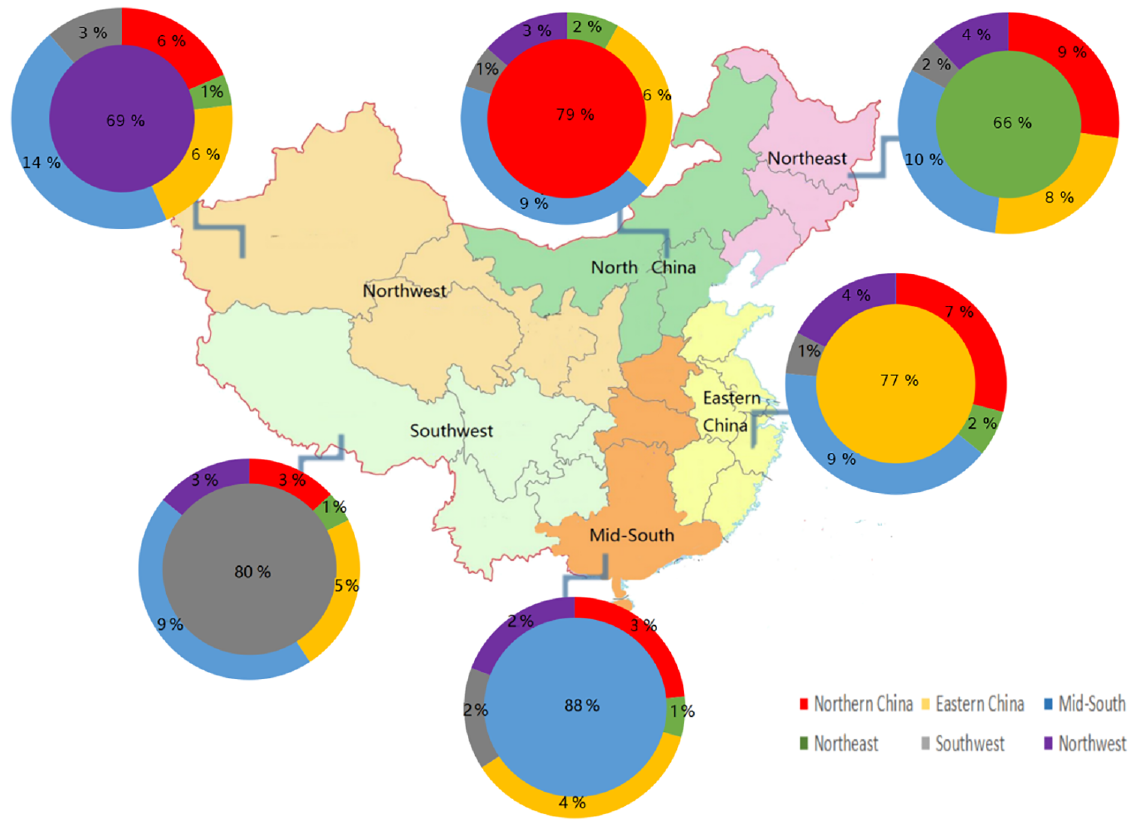
Figure 4. Regional direct and indirect economic loss from secondary sectors. The inner ring denotes the direct economic loss originating from secondary sectors inside the region, while the outer ring stands for the indirect economic loss from secondary sectors in other regions. Percentage shown on the inner ring shows the proportion of direct economic loss regarding total regional economic loss and percentages shown on the outer ring are the proportions of indirect loss from other regions relative to total regional indirect economic